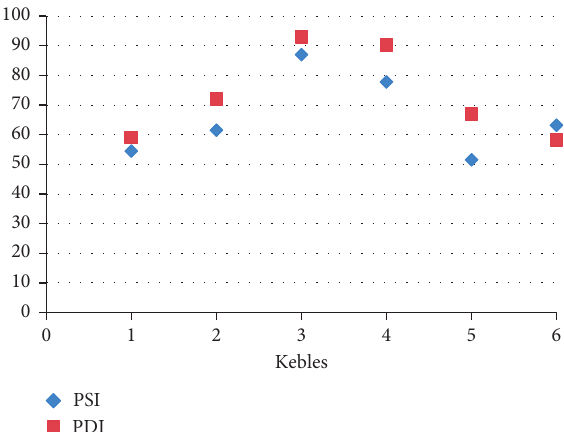
Figure 2: Percent severity index and percent disease incidence of pepper wilt disease within selected kebles. 1, Tawlla; 2, Dalga; 3, Remuga; 4, Qola-kabada; 5, Enseno; and 6,